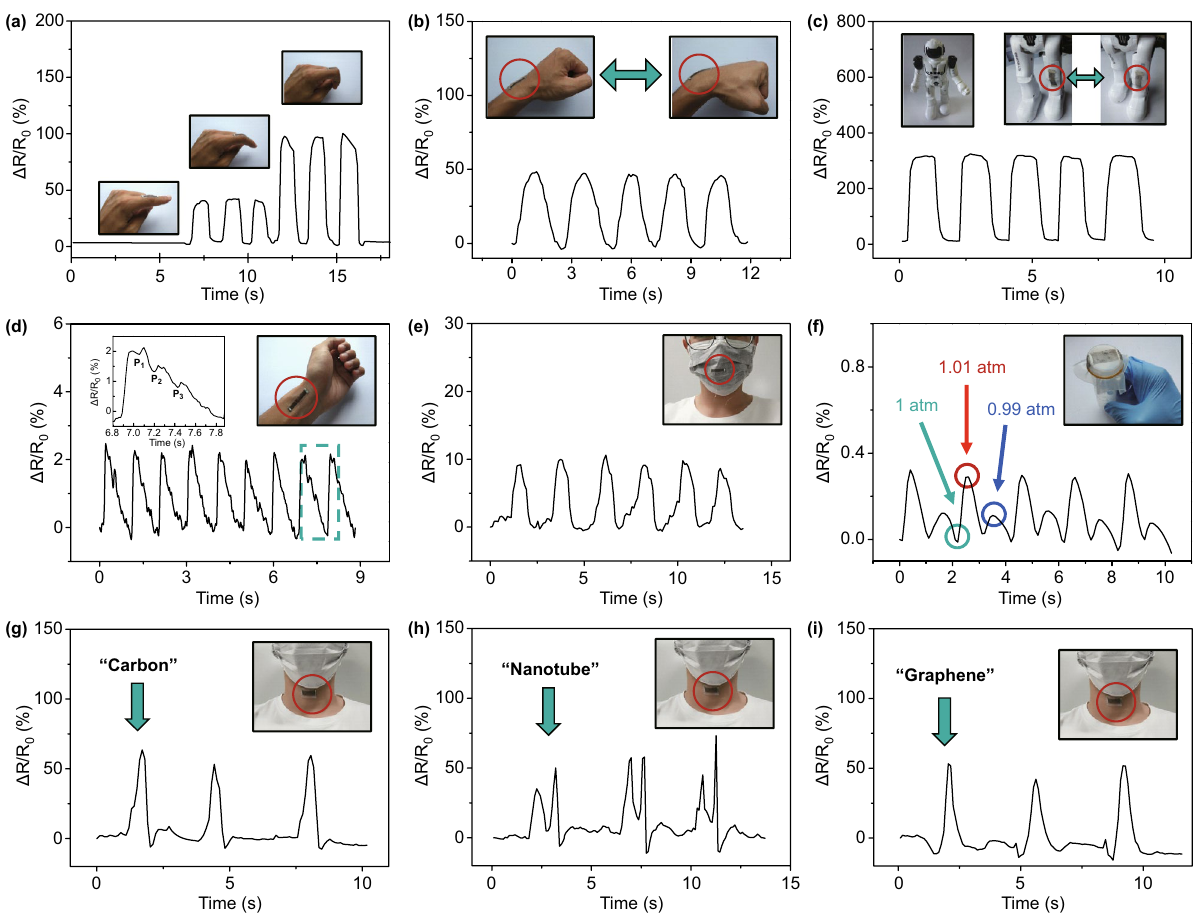
Fig. 5 Several applications of CNT-based strain sensor. a Resistance response of finger motion. b Resistance response of wrist motion. c Moni- toring the movement of a robot knee. d The pulse signal of a volunteer. e Detection of human breath through a mask. f Resistance response of tiny change of air pressure. g Monitoring the human voice with the word “Carbon”. h Monitoring the human voice with the word “Nanotube”. i Monitoring the human voice with the word